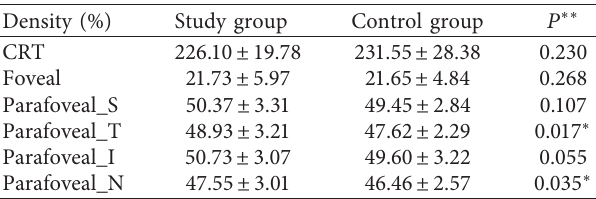
Table 2: Comparison of the mean OCT-A measurements of the eyes of patients in the study group and the eyes of the subjects in the control group (study group, n � 58; control group, n � 60).